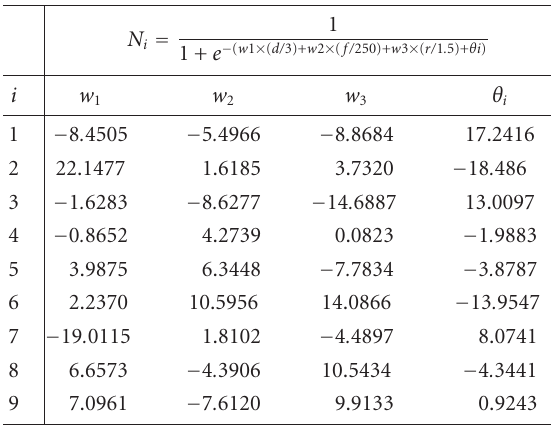
Table 12: The weights corresponding to the input layer and hidden layer.